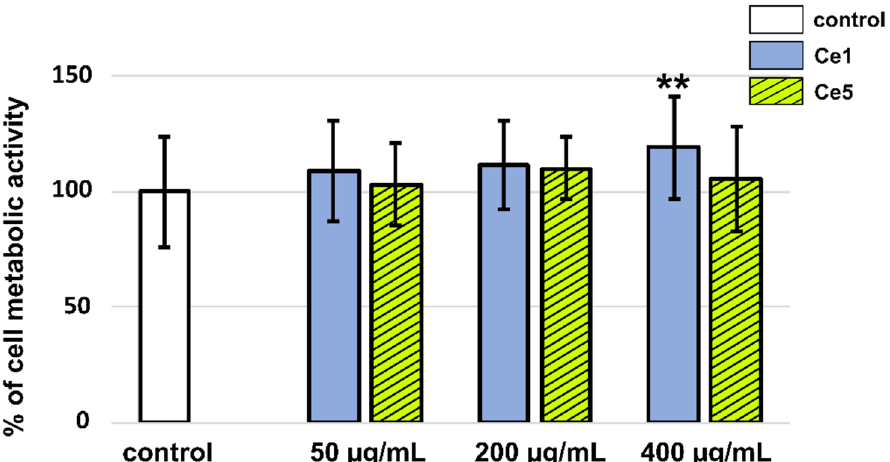
Figure 5. MTT assay of U87 MG cells in the absence (white columns) and presence of Ce1 (blue columns) or Ce5 (green hatched columns) nanoparticles at concentrations of 50, 200, and 400 μ g/mL. The level of significance was evaluated with a one-way ANOVA test (** p < 0.01 in comparison to control).